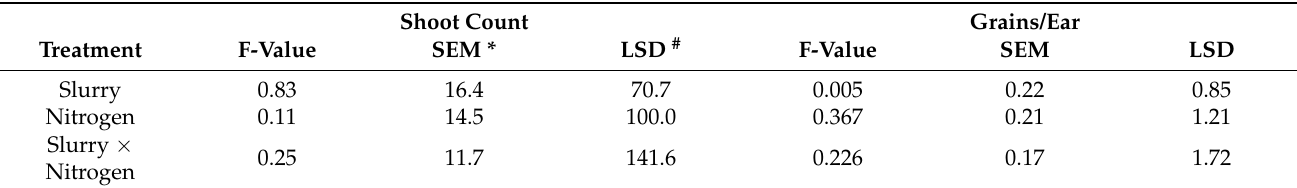
Table A2. 2016/17 REML analysis of shoot count and grains/ear. Shoot